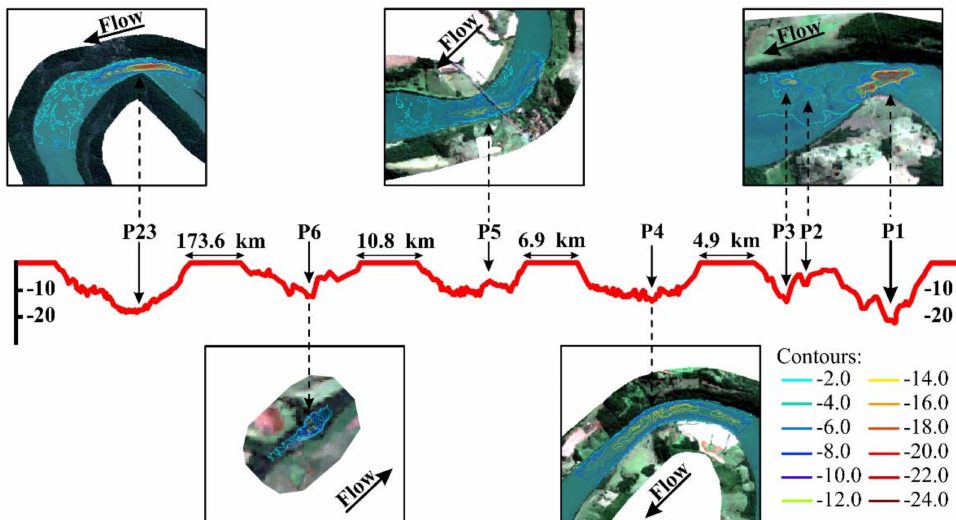
Figure 7. View of the riverbanks and general longitudinal profile of the deep pools located outside the protected area (INP) (P1, P2, P3, P4, and P5 in the main channel of the Iguaçu River, and P6 in the tributary, namely, the Capanema River) and in the protected area (INP) (P23). Horizontal arrows indicate the distances between the pools. Continuous vertical arrows indicate the places of greater depths. Dashed vertical arrows indicate the location of the pool. The red line indicates the section of